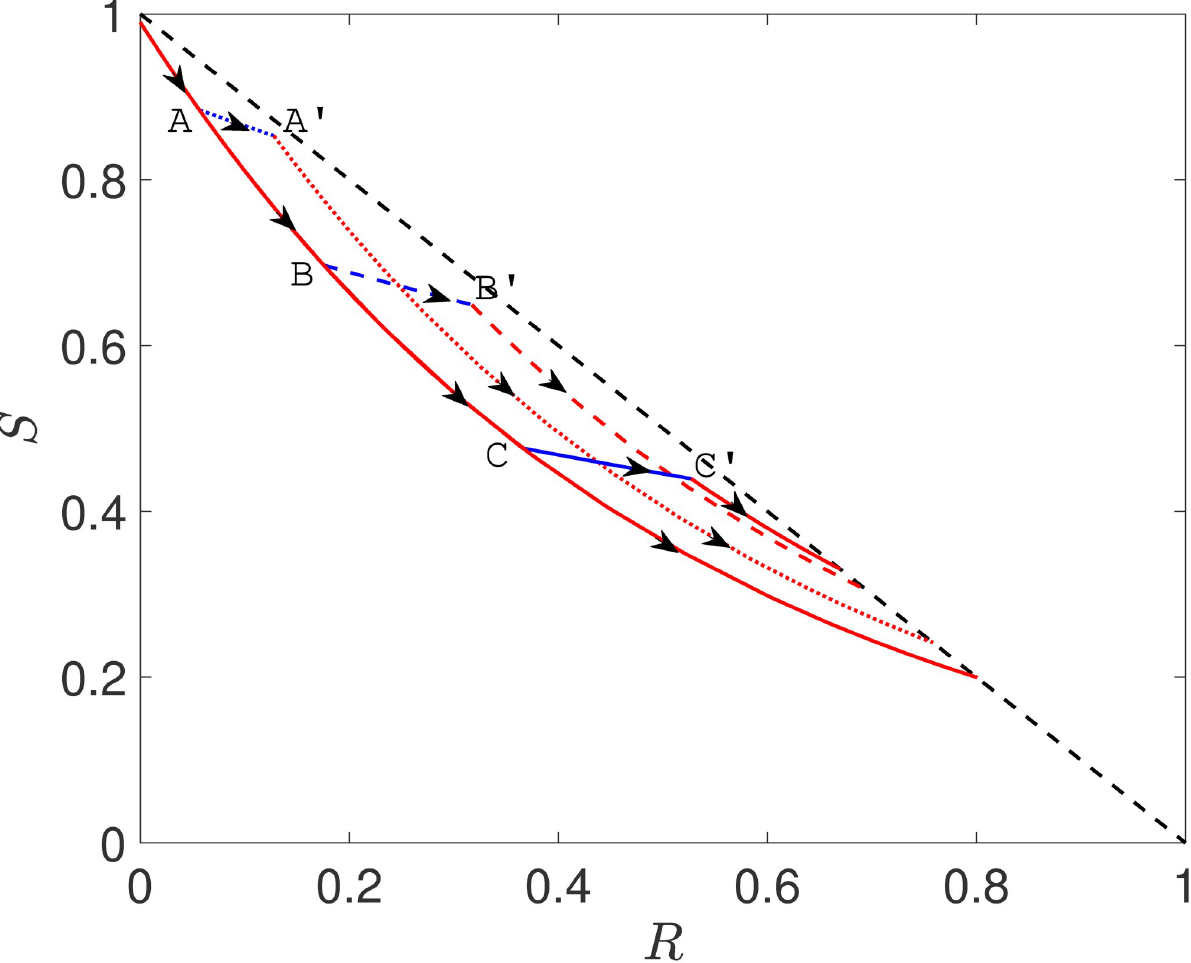
Fig 11. (S,R) phase portrait (arrows indicate growing time) based on an SIR model in a single population with β = 2, γ = 1 (giving R initial condition I (0) = 0.01. The plot shows a trajectory with no control (continuous red line) as well as three other trajectories where β = 0.5 for a time period of length D = 2 but with the intervention setting in only once I + R goes past 0.1 (partially dotted line), 0.3 (partially dashed line) and 0.5 (continuous broken line), respectively. Control for the three different scenarios sets in at the points denoted by A, B and C and control ends at A’, B’ and C’,